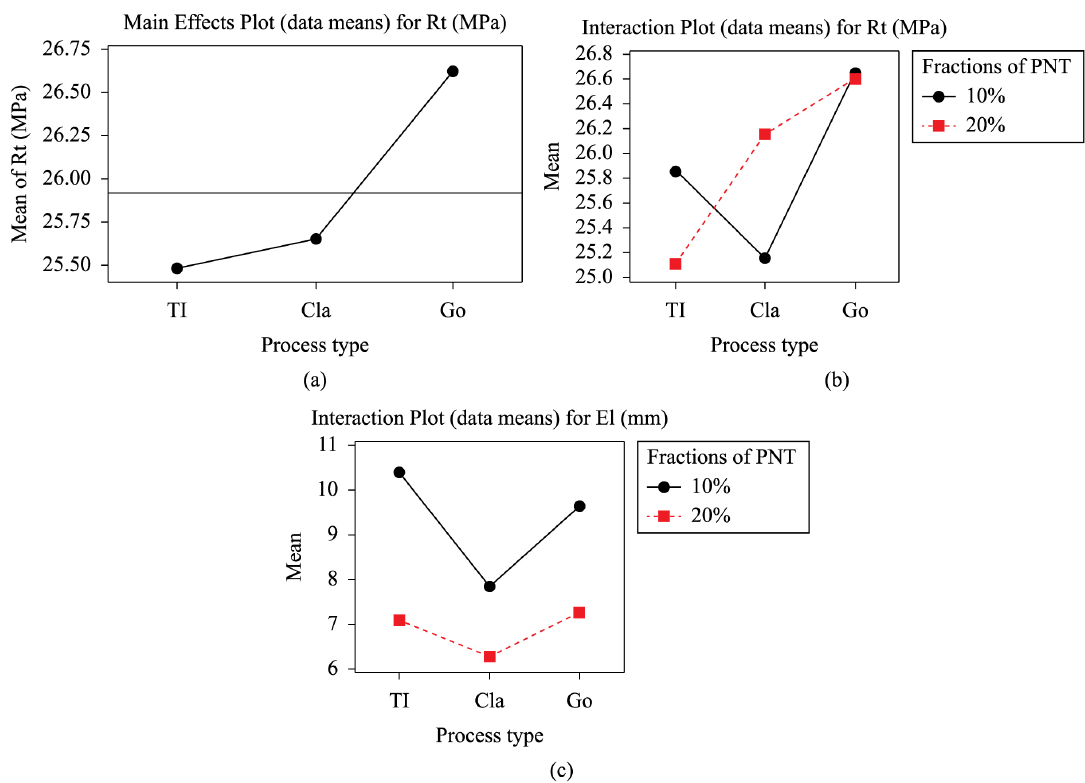
Figure 4. Major factors and their interactions (PNT) for (a, b) tensile strength and (c) maximum tensile strain through